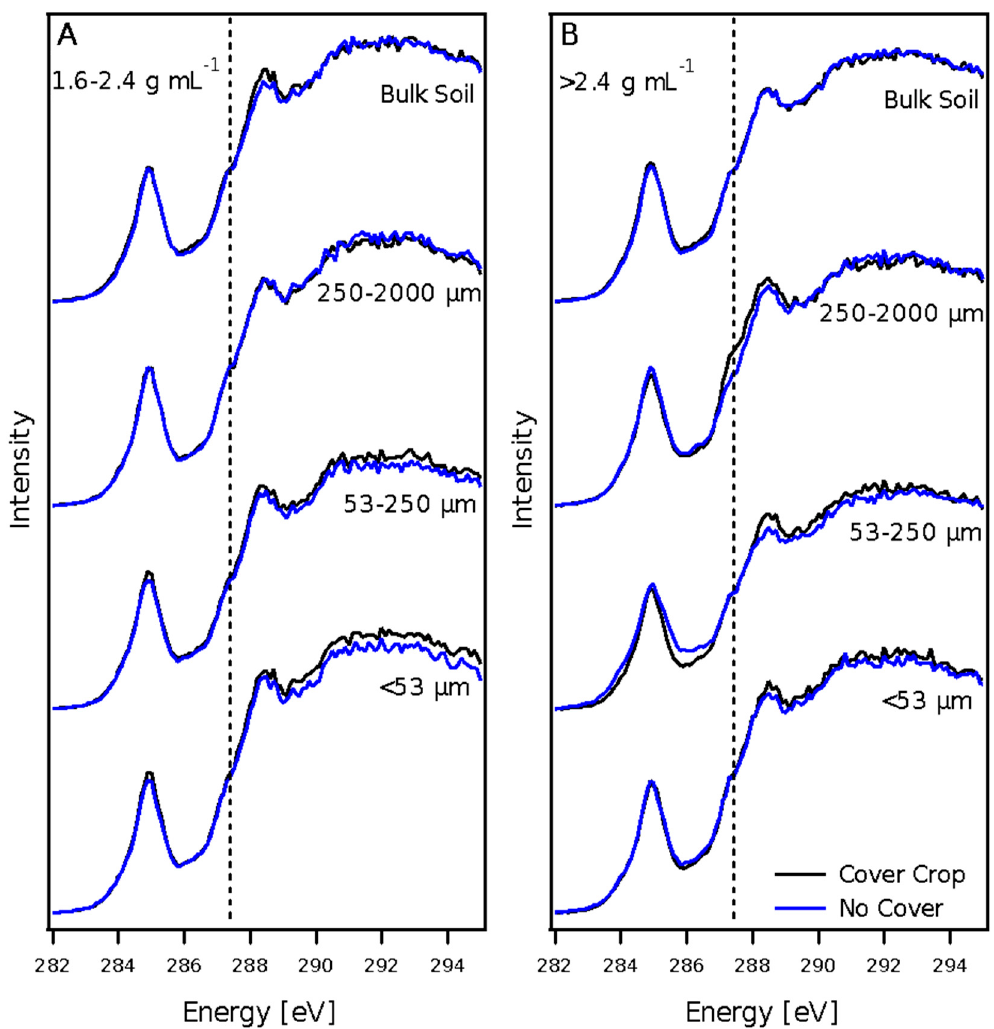
Figure 3. Carbon NEXAFS spectra of ( A ) intermediate density (1.65–2.4 g / mL − 1 ) and ( B ) heavy density ( > 2.4 g / mL − 1 ) fractions of bulk soil and sequential size-density separated samples. Black lines indicate the soil with the cover crop, and blue lines indicate no cover crop.